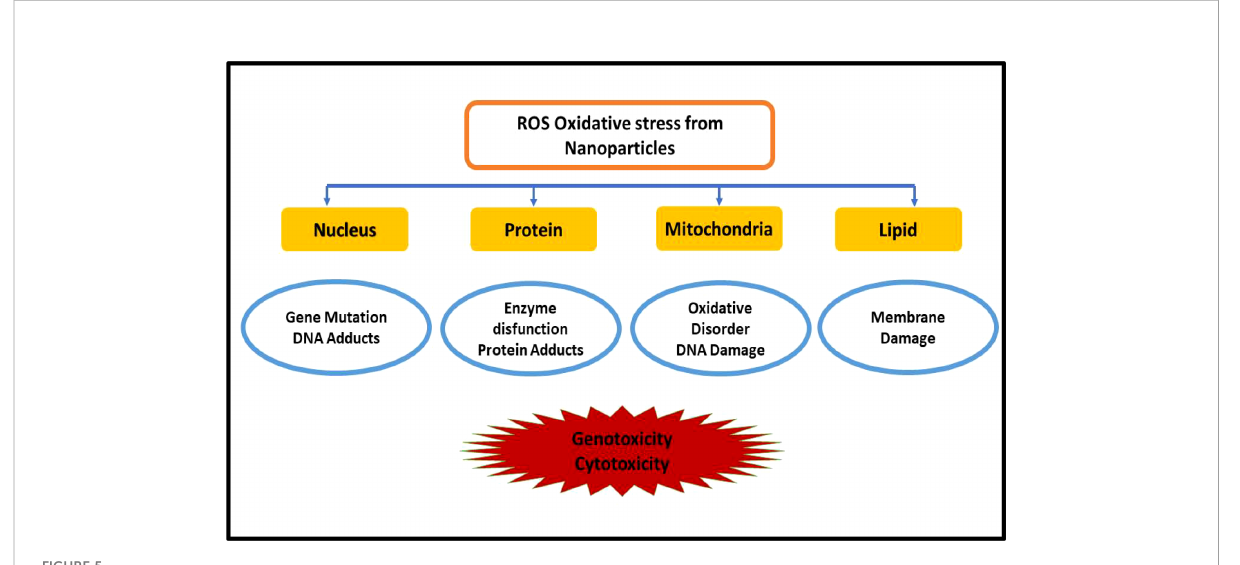
FIGURE 5 Toxicity induced by nanomaterials by ROS